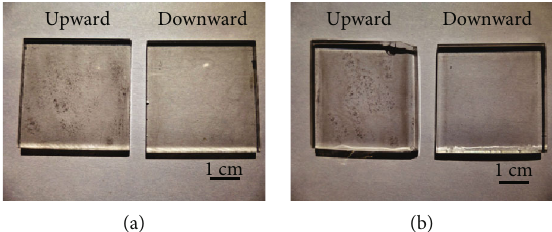
Figure 4: Photographs of the (a) PMMA and (b) glass substrates on the downward and upward systems after 20 months of exposure (May 24, 2016).